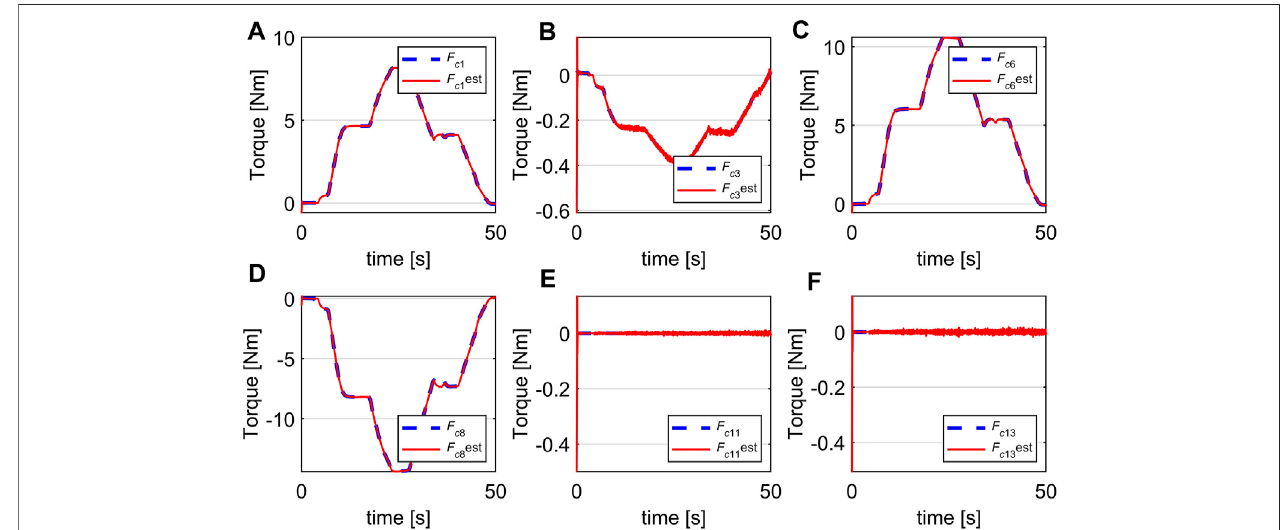
FIGURE 13 | Estimation of marker positions, (A) y 1 , (B) y 6 , (C) y 11 , (D) y 13 , (E) y 14 , (F) y 15 .